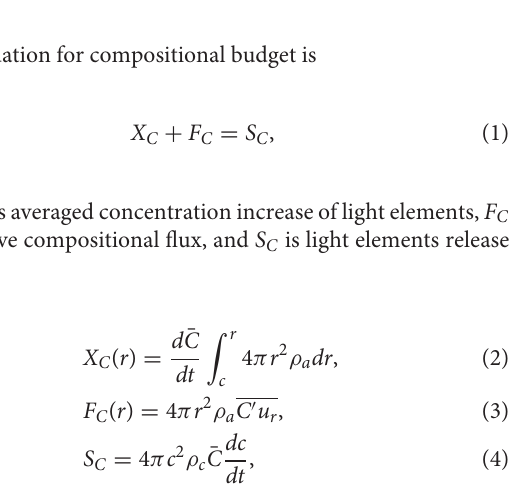
FIGURE 1 | The thickness of a stable layer depending on the extent of penetration of